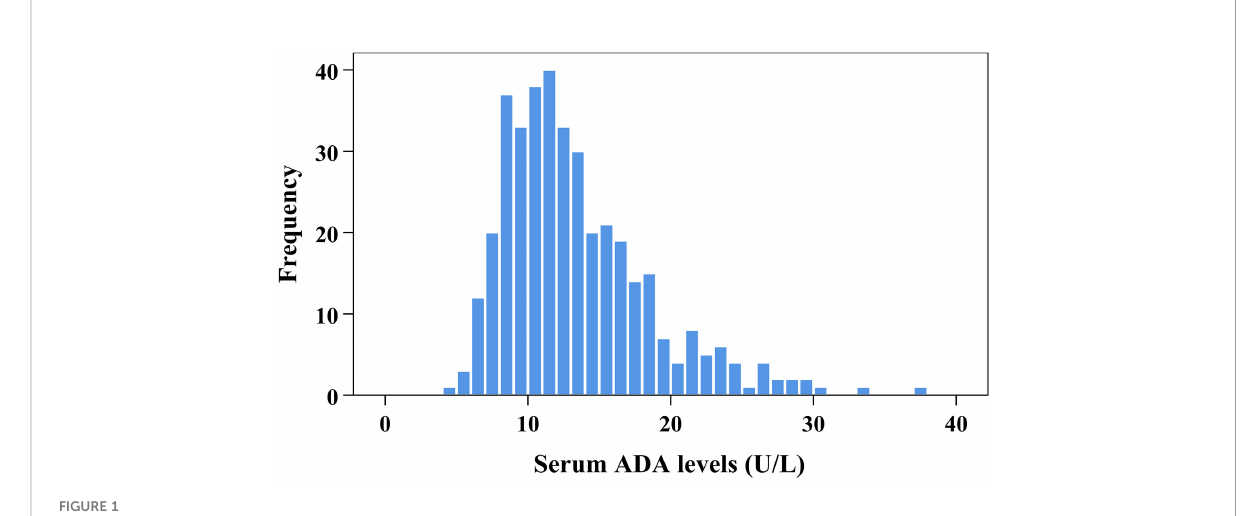
FIGURE 1 Frequency distribution of serum ADA